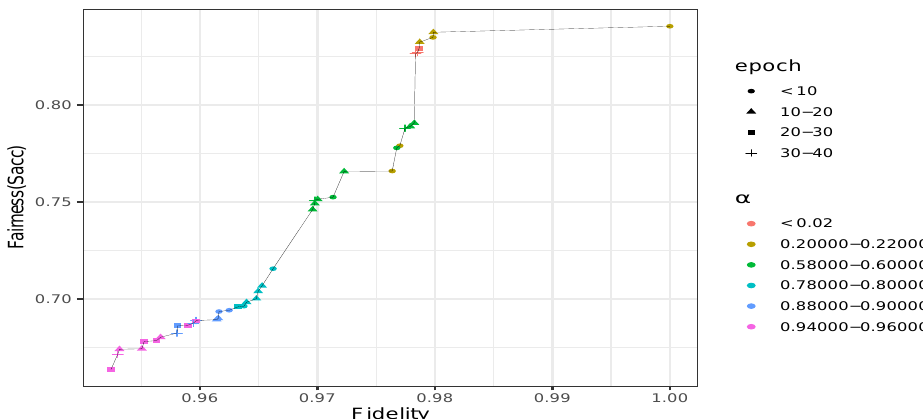
Figure 3. Fidelity-fairness trade-off on Adult. Each point represents the minimum possible sAcc of all the external classifiers. sAcc decreases with the increase of α , a small value providing a low fairness guarantee while a larger one usually introduced a higher damage. Remark that even with α = 0, a small damage is to be expected. Points whose fidelity = 1 (lower right) represent the BER on the original (i.e., unperturbed)